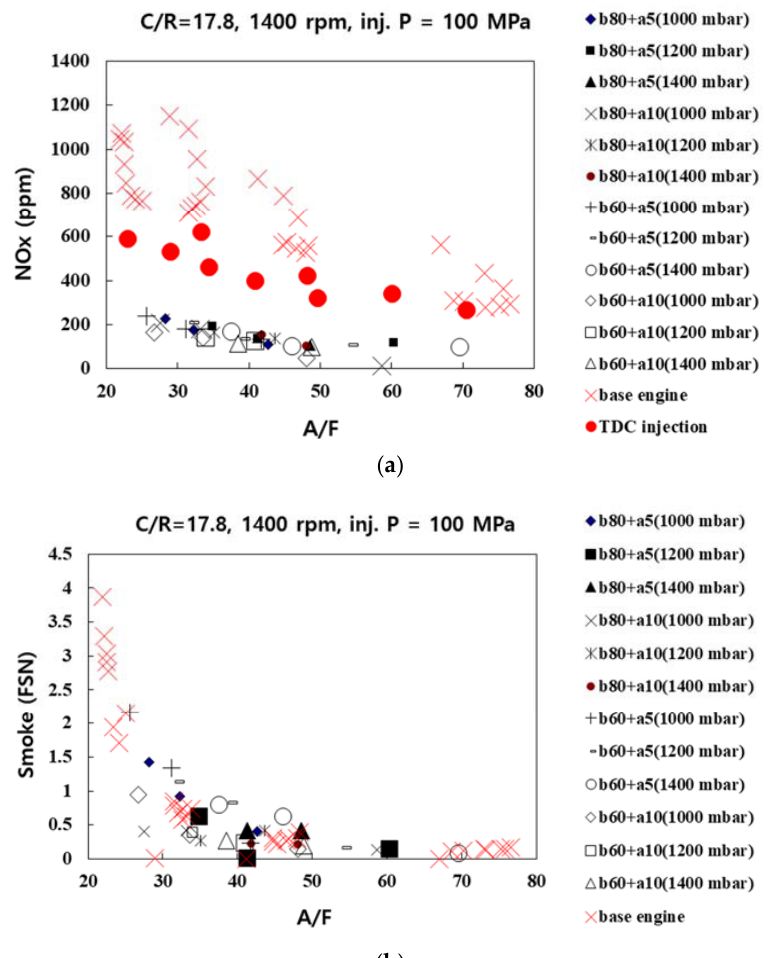
Figure 6. Characteristics on the emissions of NO x and smoke in accordance with the air ‐ fuel ratio (multiple injection mode). ( a ) NO x characteristics according to the air ‐ fuel ratio; ( b ) smoke characteristics according to the air ‐ fuel ratio.